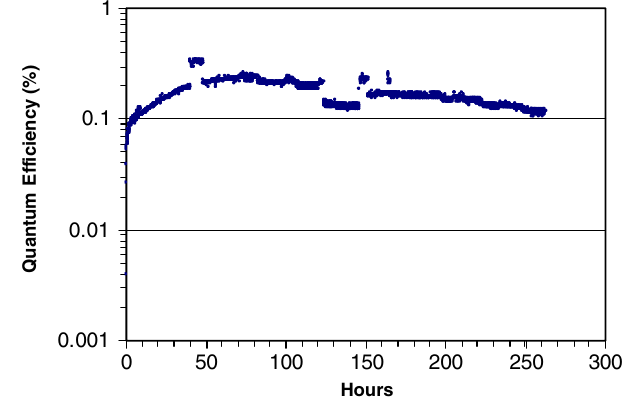
FIG. 6. (Color) The quantum efficiency of a CsBr = Cu photo- cathode was measured in open loop for a relatively long time > 250 hours without great deleterious effects. Spikes and offsets were due to laser fluctuations and external vibrations that caused jumps in the quantum efficiency due to illuminated spot motion. The laser power density was (cid:2) 5 (cid:4) 10 5 W = cm 2 for a spot size of 1 : 5 (cid:1) m diameter. The behavior of the Q.E. with time is ex- plained in Refs. [2–6] in terms of intraband excitations, direct electron injection from metal substrates, Cs migration, and contamination.